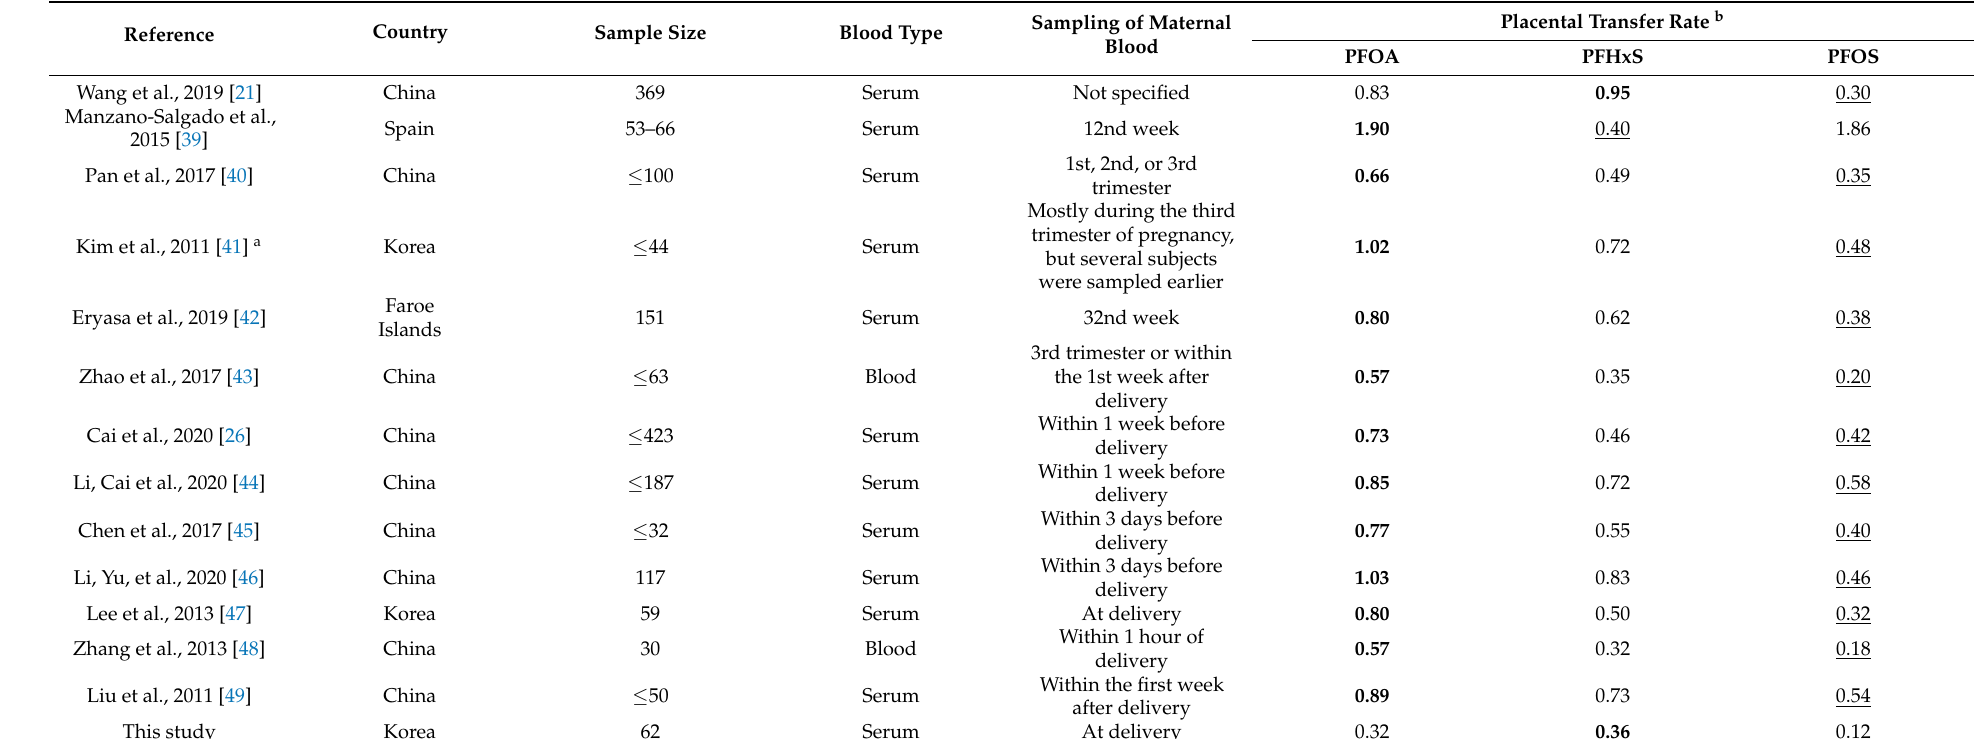
Table 3. Placental transfer rates of PFASs in the previous literature and this